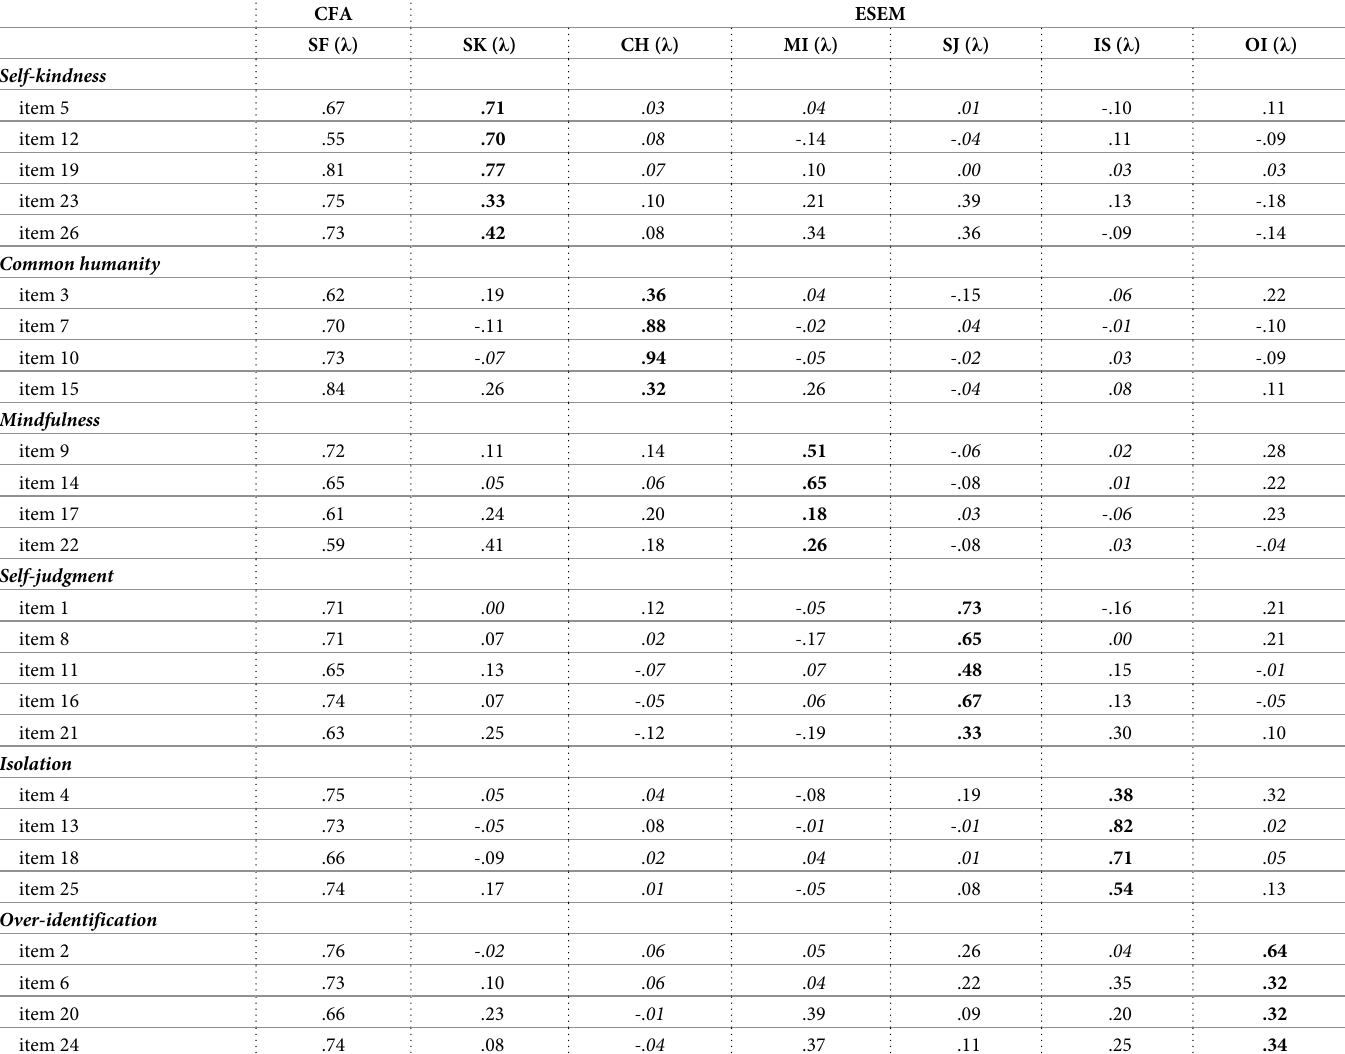
Table 2. Standardised factor loadings for the six-factor model: CFA and ESEM